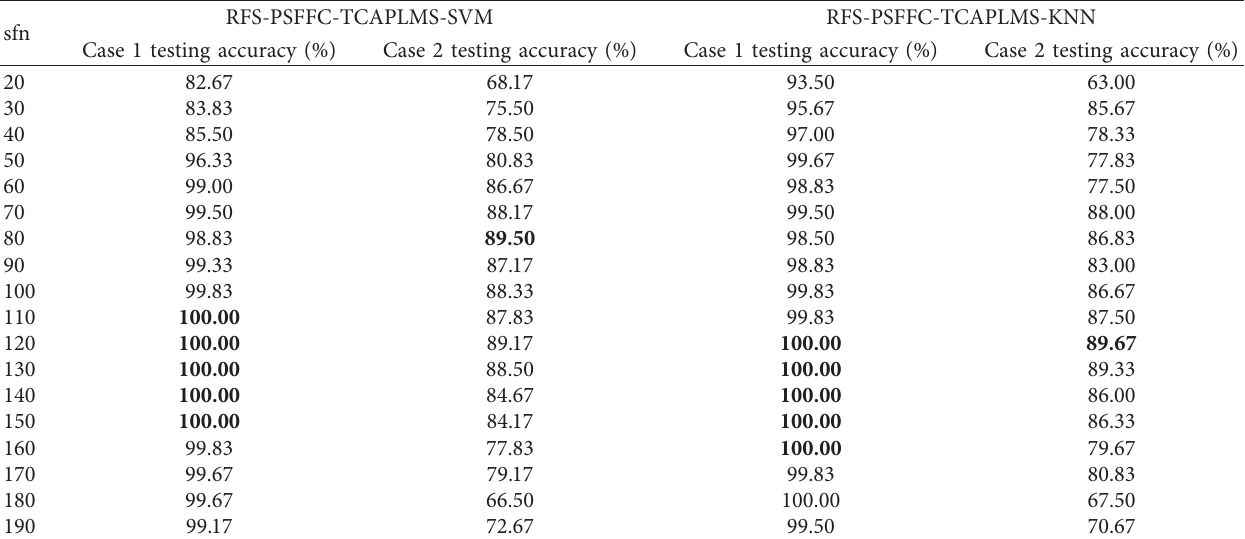
Table 16: The testing accuracies of RFS-PSFFC-TCAPLMS-SVM and RFS-PSFFC-TCAPLMS-KNN (the dimension size is 20). RFS-PSFFC-TCAPLMS-SVM RFS-PSFFC-TCAPLMS-KNN sfn Case 1 testing accuracy (%)